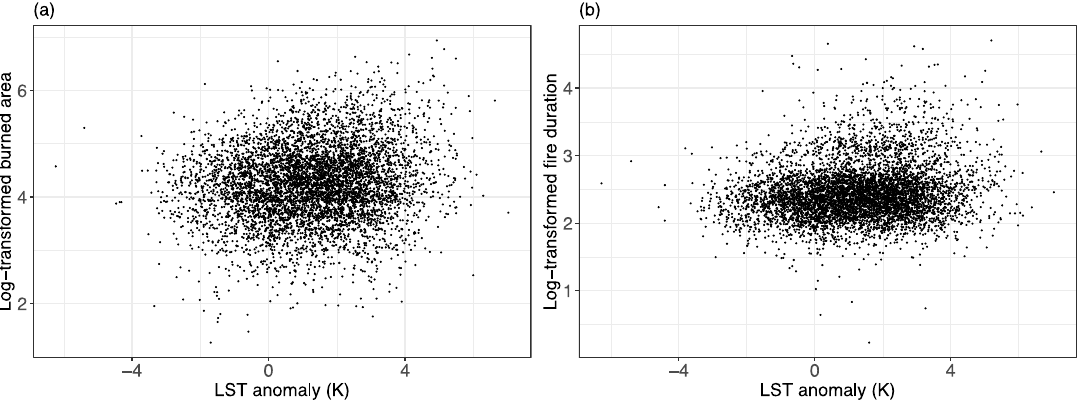
Figure 7. Scatterplot of log-transformed burned area ( a ) and log-transformed fire duration ( b ) against LST anomaly.